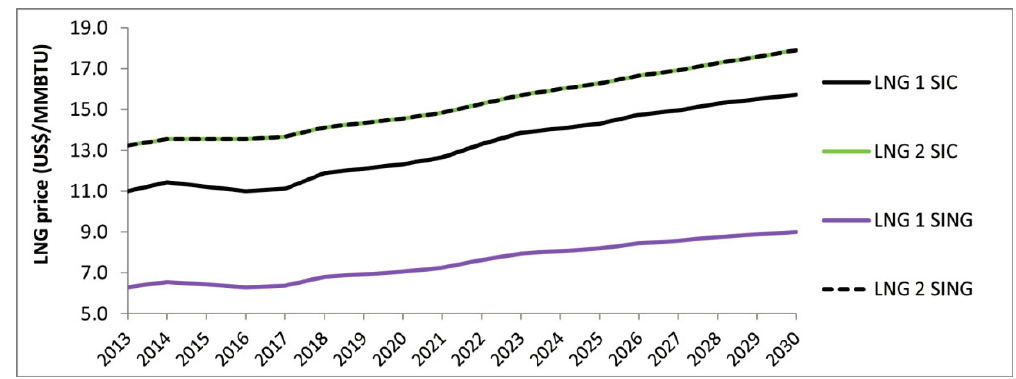
Figure 15. LNG prices projection. LNG 1 SIC and LNG 1 SING are the prices of LNG for plants which have open access to the LNG terminal in SIC and SING, respectively. LNG 2 SIC and LNG 2 SING is the price for plant which have not open access to LNG terminal. Conflicts of Interest The authors declare no conflict of